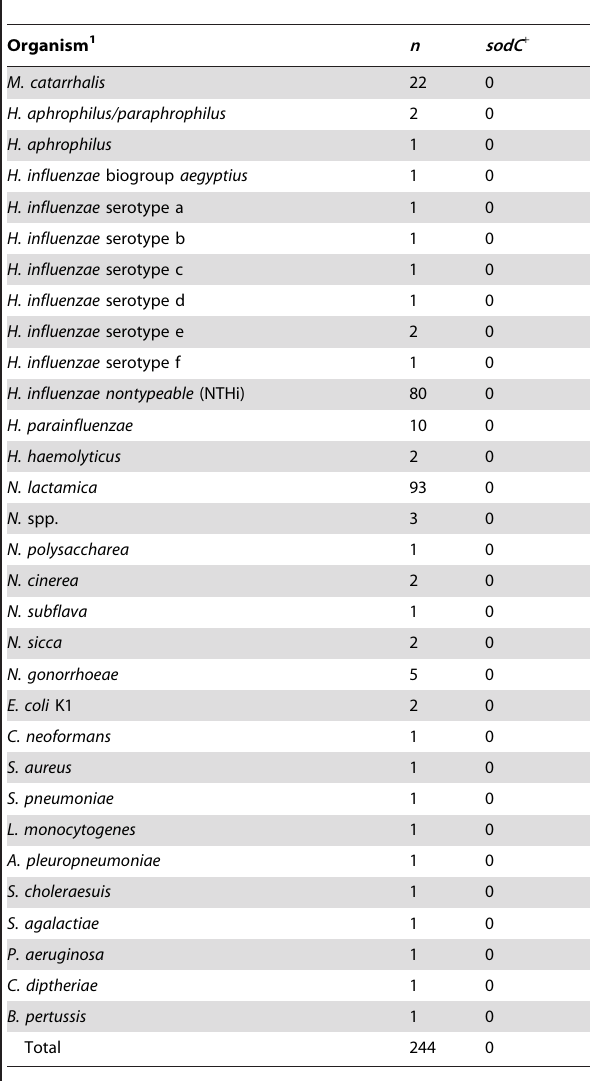
Table 2. 244 non-Nm isolates were used to test the specificity of the sodC